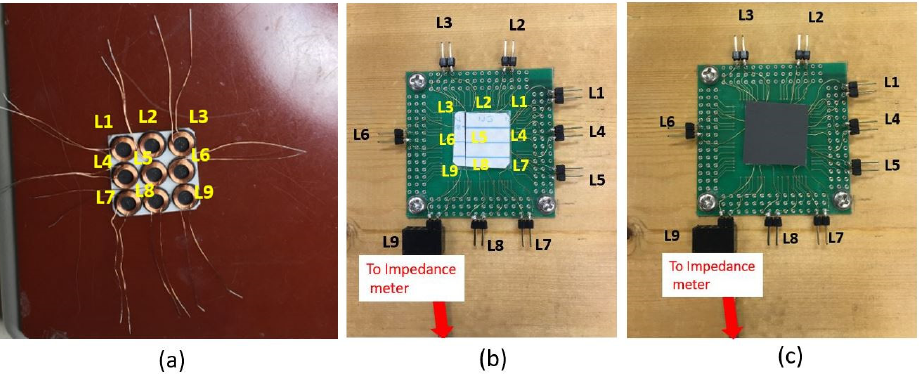
Figure 3. Coils array device fabrication: ( a ) 3 × 3 coils, ( b ) array glued on the PCB, and ( c ) with a 20 × 20 mm 2 sample. Here the inductance L9 is connected to the impedance meter for measurement.